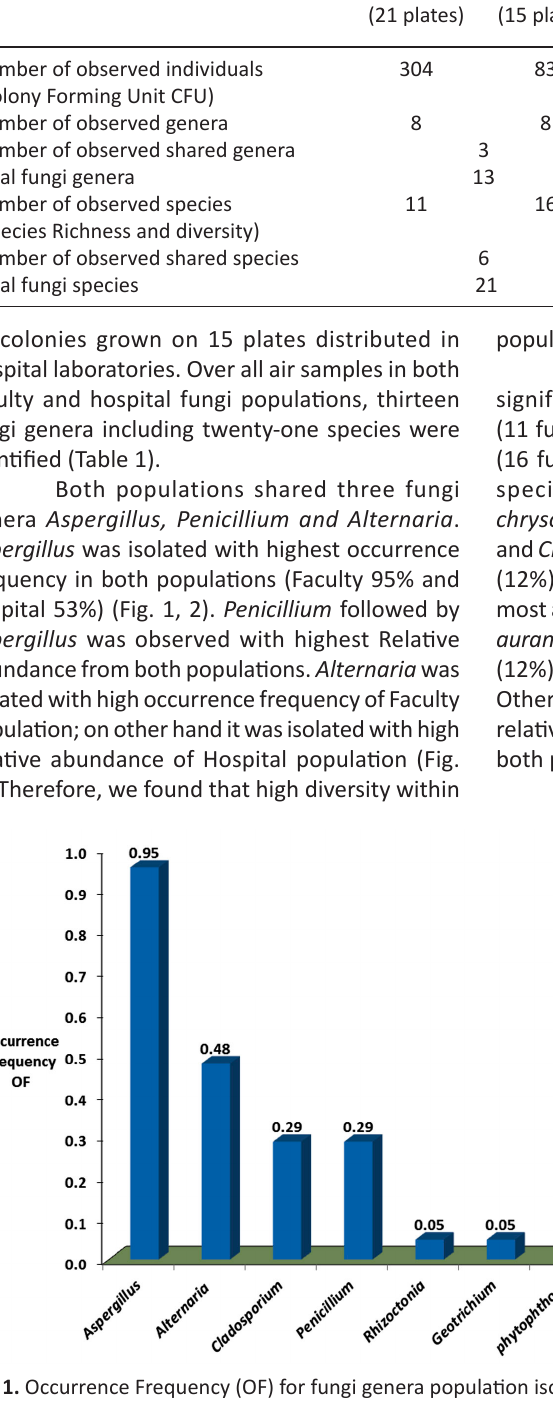
Table 1. General statistics of airborne fungi populations from faculty and hospital laboratories Parameters